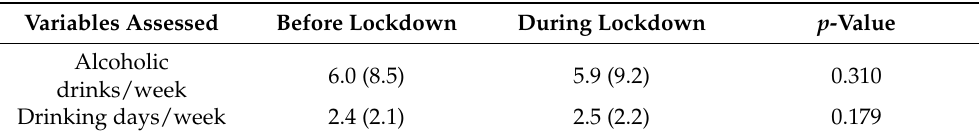
Table 2. Alcohol consumption before and during